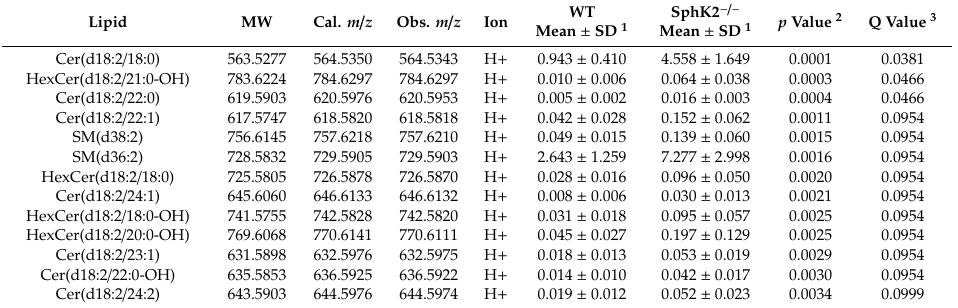
1 Mean and Standard Deviation (SD) have been reported in nmoles / mg tissue; 2 Unadjusted and 3 adjusted p -values for multiple comparisons (Q values) are reported. MW: Molecular weight; Cal. m / z : calculated mass-to-charge ratio; Obs. m / z : observed mass-to-charge